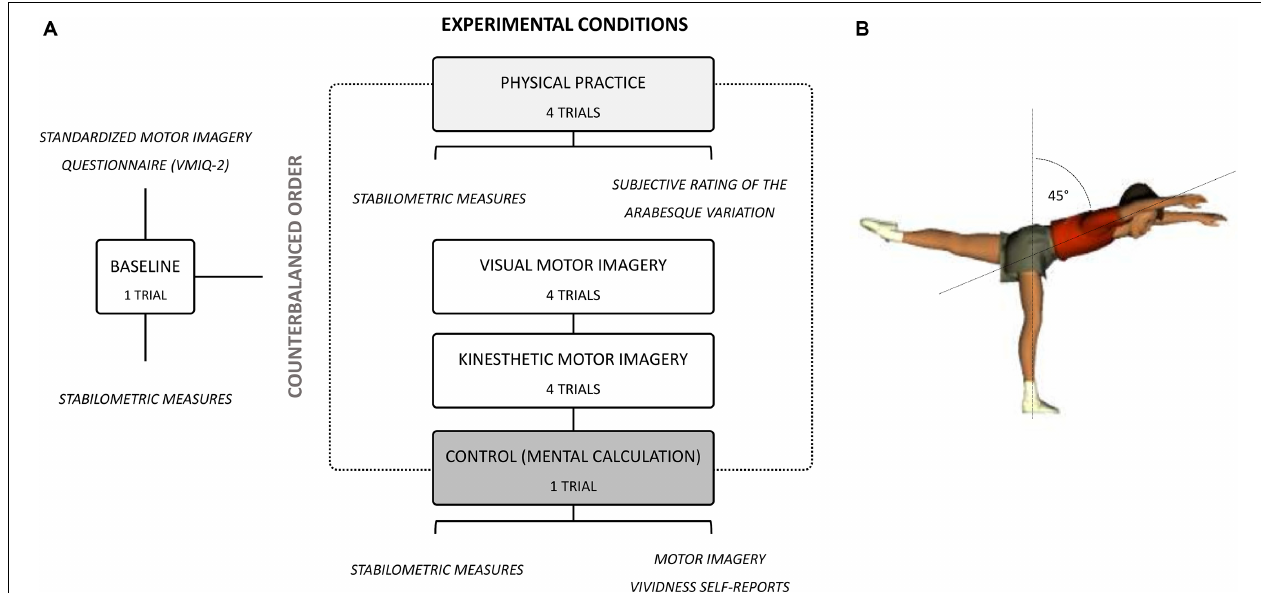
FIGURE 1 | (A) Flowchart of the experimental design. (B) Graphic representation of the arabesque variation administered during stabilometric recordings under physical practice, visual MI, kinesthetic MI, and control experimental conditions.